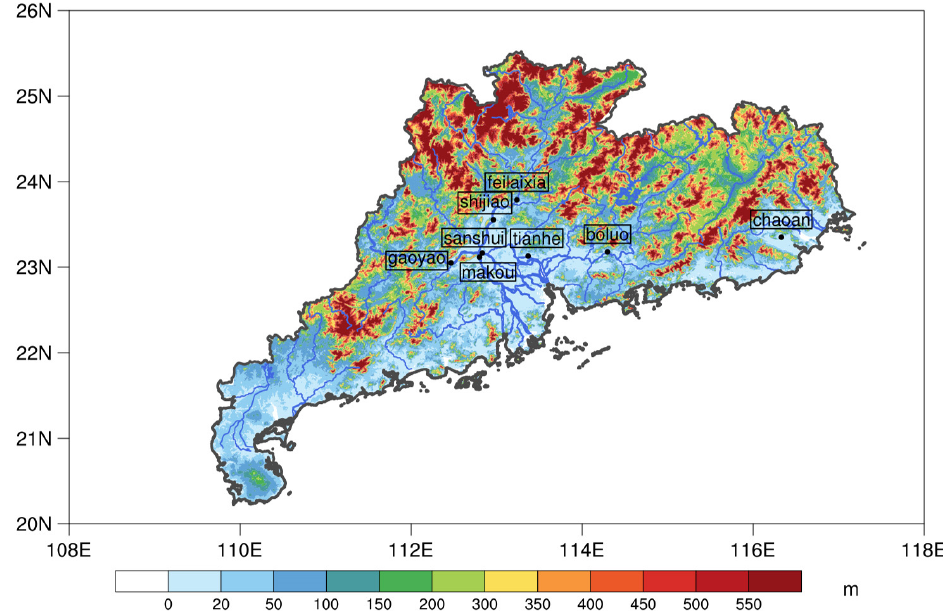
Figure 1. Topography and locations of stations in Guangdong; blue lines are